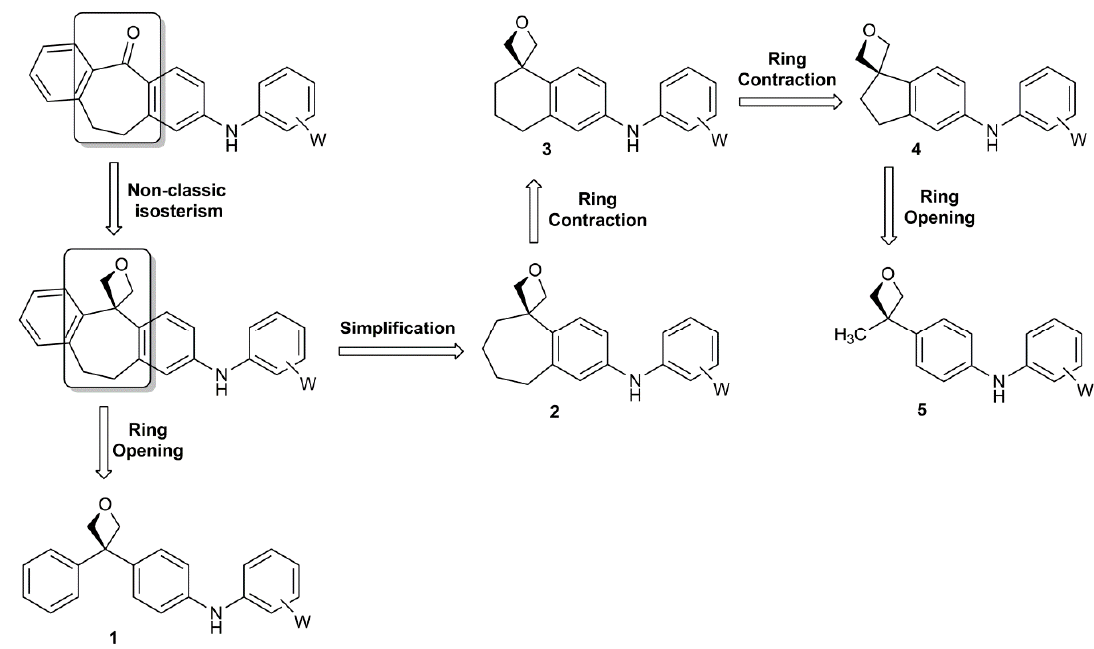
Figure 3. Design of new oxetane derivatives.